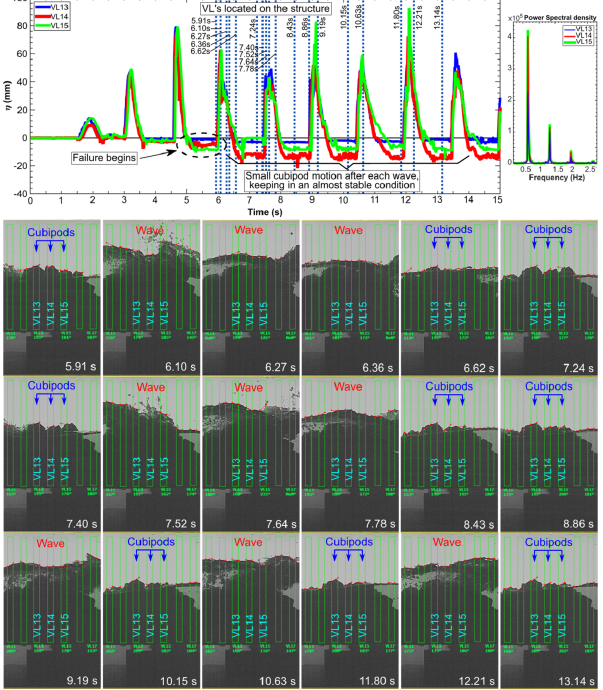
Figure 11. Detection of failure of the Cubipods located at the top of the structure through the analysis of virtual levels (VLs). Above: comparison of the edge displacement measurements taken by the VLs 13, 14 and 15, which were placed on the structure, including the power spectral density of the signals. When water moved inside these VLs, they detected the upper water surface. When the wave passed, the VLs detected the edge of the Cubipods located at the top of the structure. Below: representative snapshots at different time